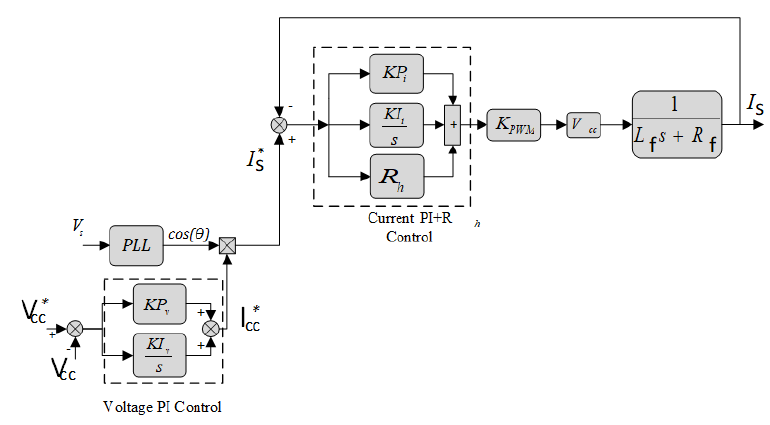
Figure 8. Block diagram of grid connected mode inverter control